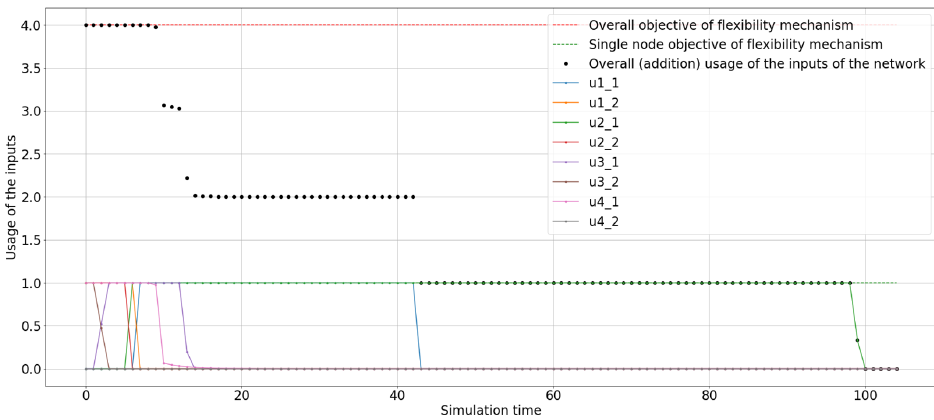
Figure 11. Solution for u-variables of the decentralised MPC.